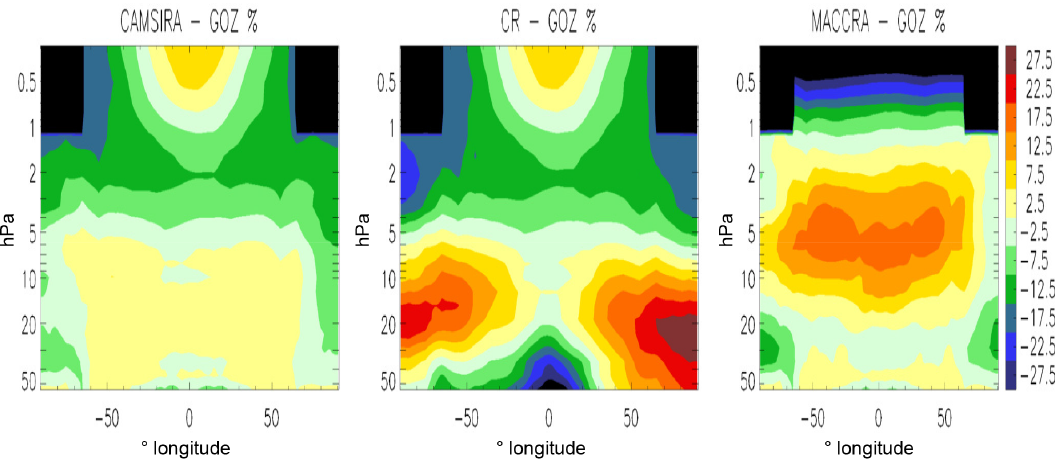
Figure 19. Cross sections (50–0.3hPa) of the relative biases of zonally averaged ozone (%) of CAMSiRA (left), the CR (middle) and MACCRA (right) compared with the GOZCARDS product (GOZ) for the period